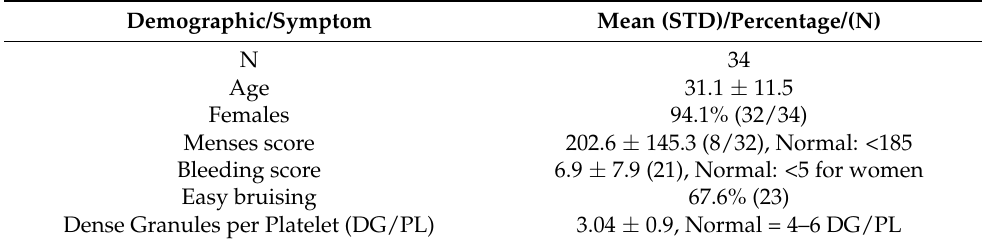
Table 1. Characteristics and co-morbidities of patients with postural orthostatic tachycardia syndrome.